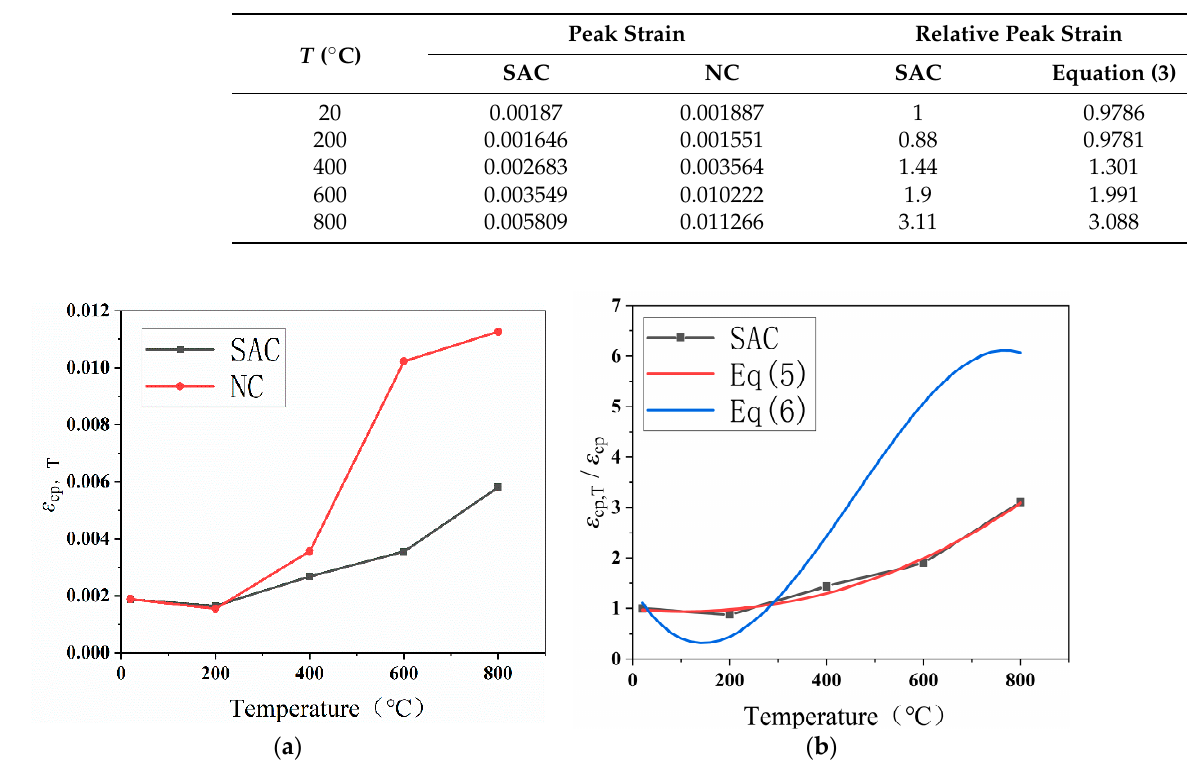
Figure 9. Peak strain of specimens after high temperature: ( a ) Peak strain, ( b ) Relative peak strain.